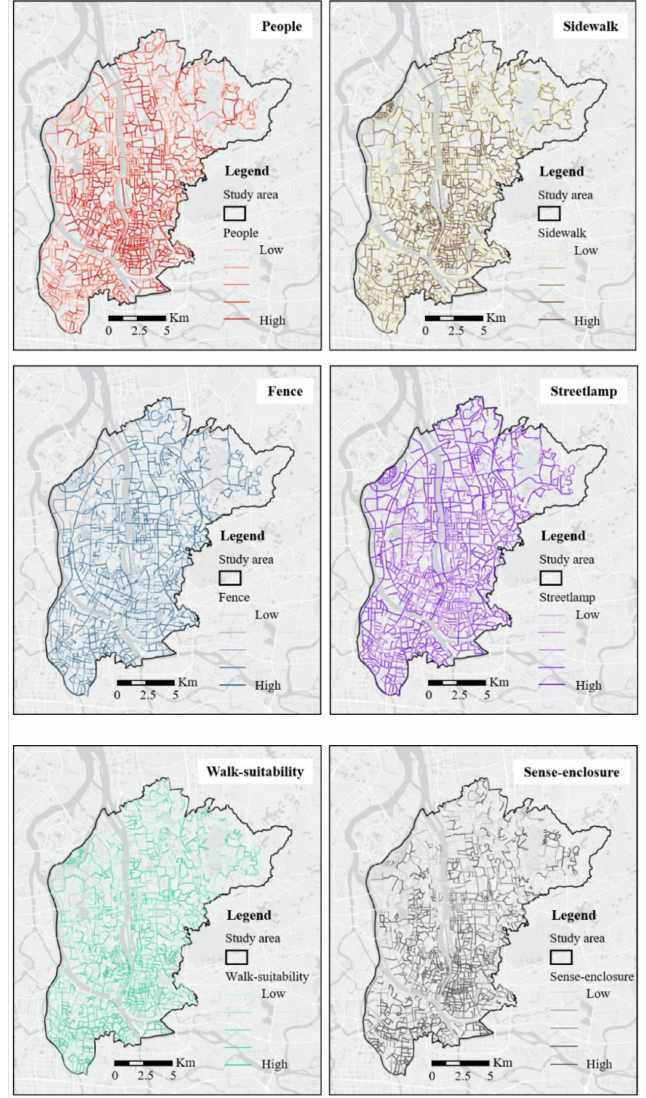
Figure 4. Examples of spatial distributions of street view